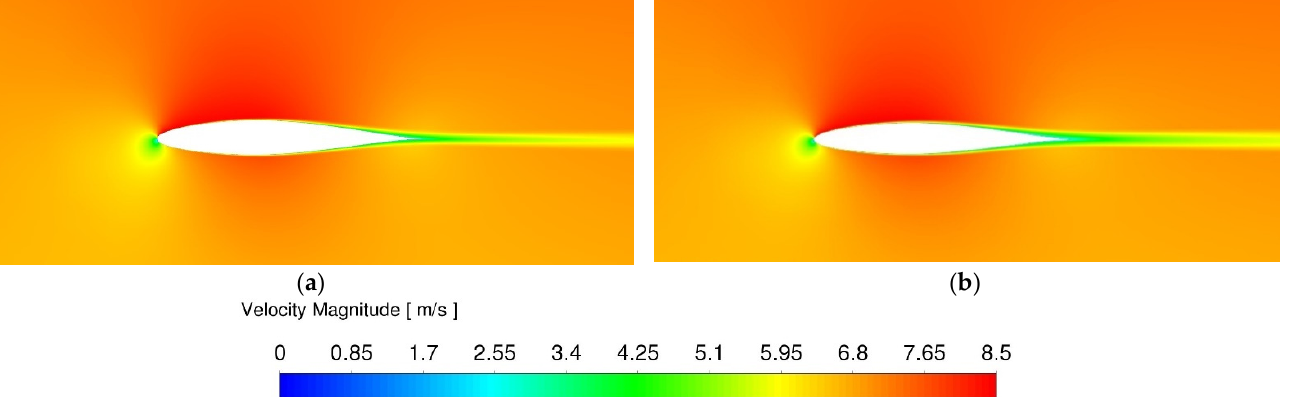
Figure 15. Contours of static pressure over the original model at angle of attack ( a ) 0° in one-phase flow, ( b ) 0° in two-phase flow, ( c ) 16° in one-phase flow, and ( d ) 16° in two-phase flow.